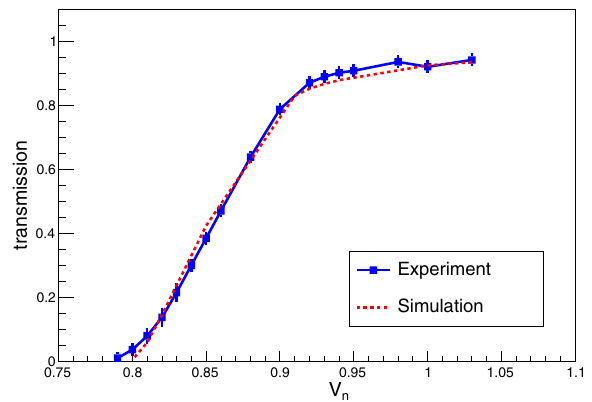
FIG. 10. Measured and simulated transmissions of epRFQ as functions of the inter-vane voltage V n . This measurement was performed with a beam width of 50 μ s and a repetition rate of 25 Hz. The error bars are derived from the fluctuation of the spectrum measurement using the FCT.